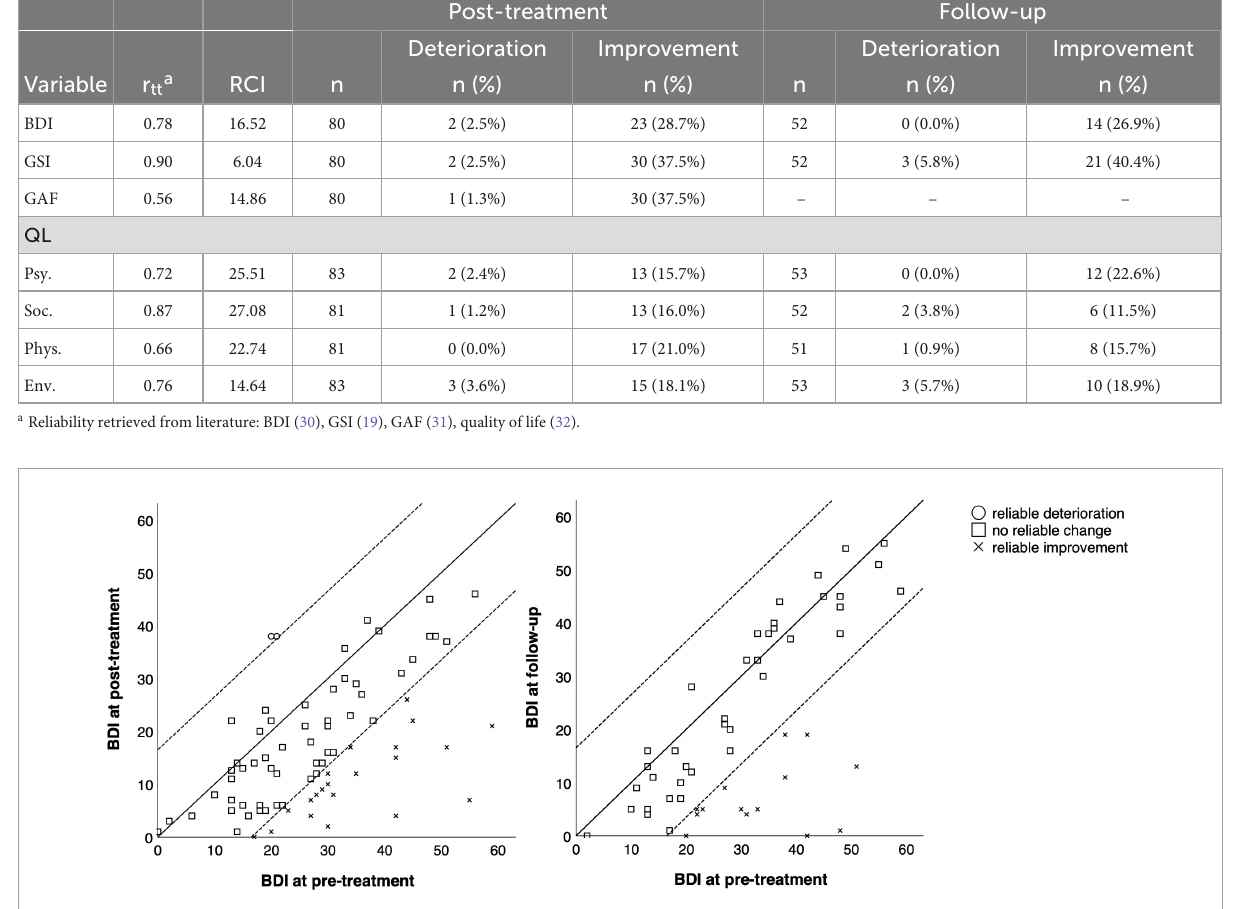
FIGURE2 Comparison of pre-treatment, post-treatment, and follow-up scores in the BDI for each participant. Reliable change index was calculated according to Jacobson and Truax (24).